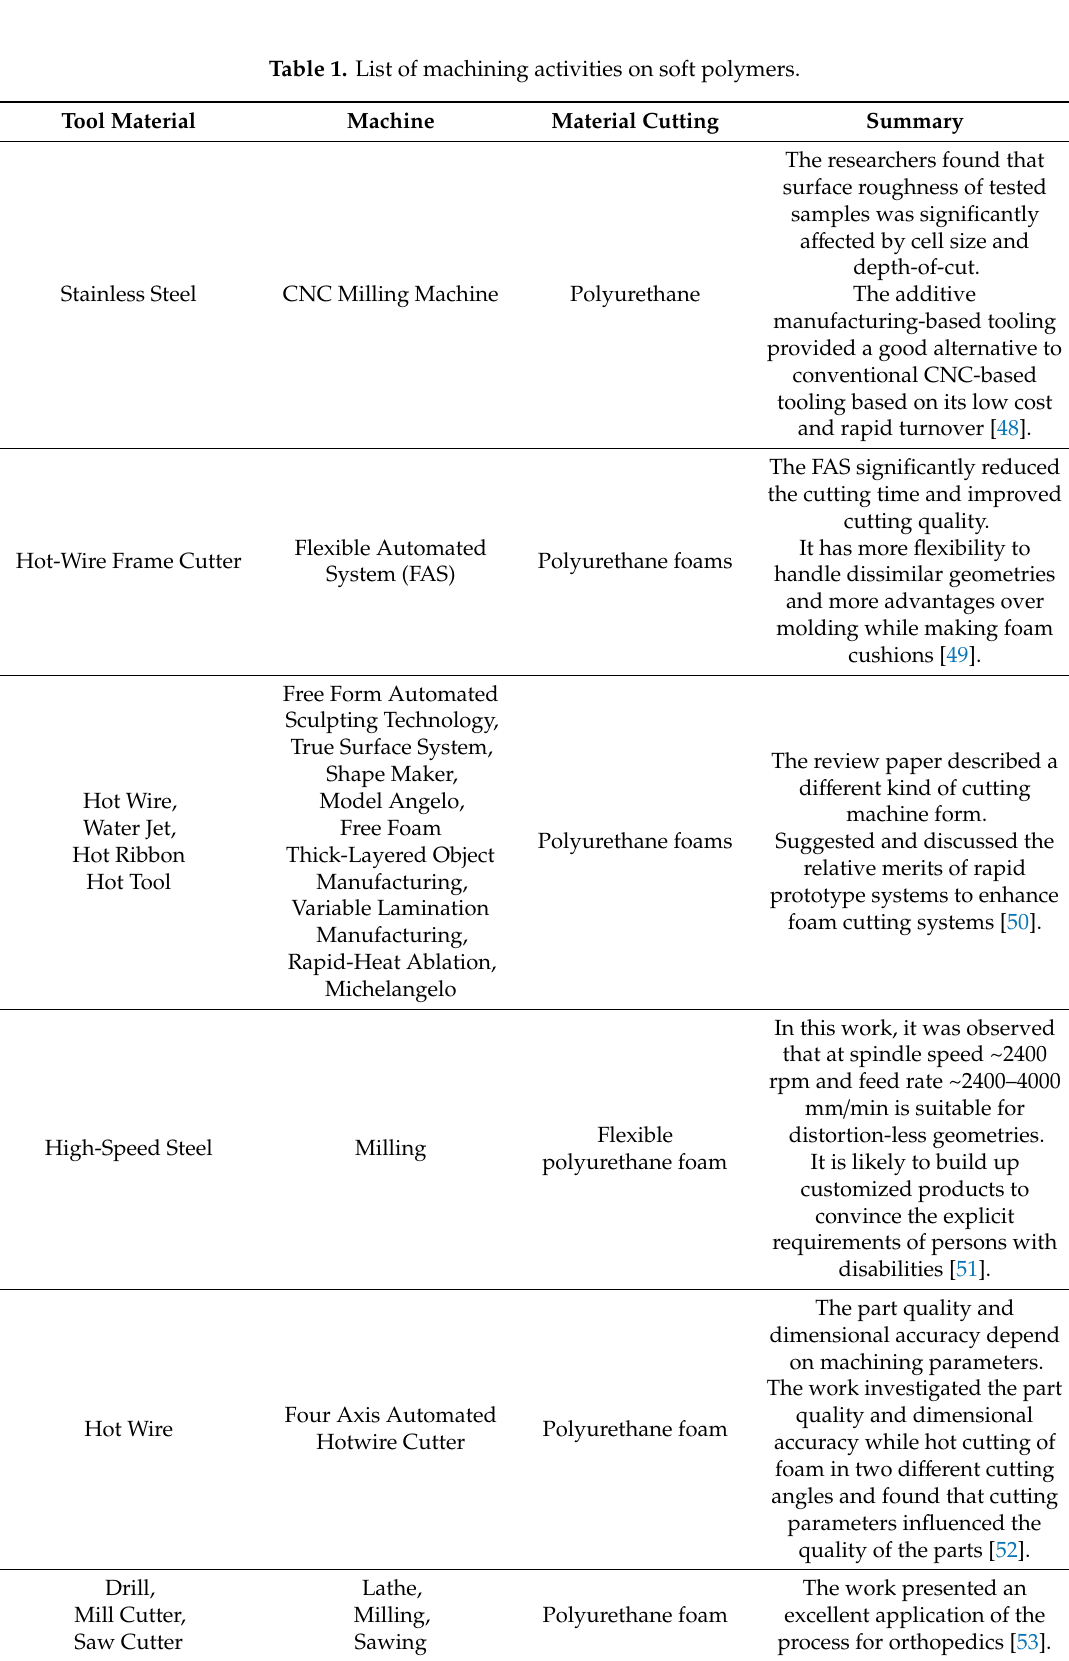
Table 1. List of machining activities on soft